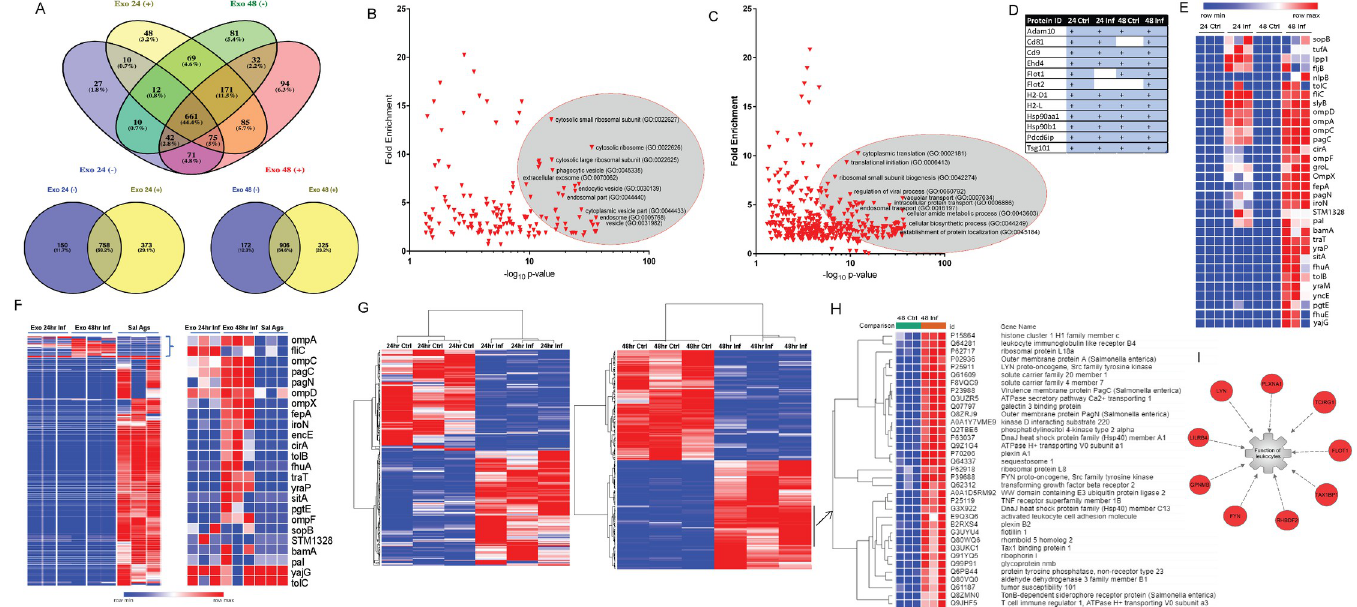
Fig 2. Proteomic analysis of exosomes isolated from S . Typhimurium-infected macrophages. (A). Venn Diagrams of the number of proteins identified in exosomes derived from macrophages infected for 24 [Exo 24 (+)] and 48 hours [Exo 48(+)] with S . Typhimurium in comparison to exosomes from uninfected cells [Exo 24 (-)] and Exo 48(-)] isolated at the same time points. The graphs show confidently identified proteins in at least two out of three replicates. ( B-C ). Scatterplot of GO terms associated with exosomal proteins identified at 48 hpi in at least two replicates. GO terms were analyzed using the PANTHER overrepresentation test. GO terms defining subcellular localization (B) and biological function (C) are both shown. (D). Identified exosomal markers in each category of samples. (E). Heat map of S . Typhimurium antigens identified in exosomes derived from macrophages infected for 24 (24 Inf) and 48 hours (48 Inf) with S . Typhimurium in comparison to exosomes from uninfected cells (24 Ctrl and 48 Ctrl) isolated at the same time points. (F). Heat map of S . Typhimurium antigens identified in exosomes at 24 hpi and 48 hpi compared in relative intensities to the proteins identified in the total Salmonella antigen preparation (Sal Ags). (G). Heat map of hierarchical clustering analysis of exosomal proteins, which were differentially expressed in exosomes from 24 and 48-hour infection meeting fold change of -2/+2. Proteins, which were not significantly altered upon infection, are not included in the graph. (H-I). Hierarchical clustering analysis of exosomal proteins identified in exosomes 48 hpi. Ingenuity Pathway Analysis was used to analyze one of the specific sub-clusters [indicated with an arrow in (F) ]. The most significant represented pathway of this sub-cluster was related to the function of leukocytes. The red color indicated the upregulation of the molecules at 48 hpi in comparison to control.